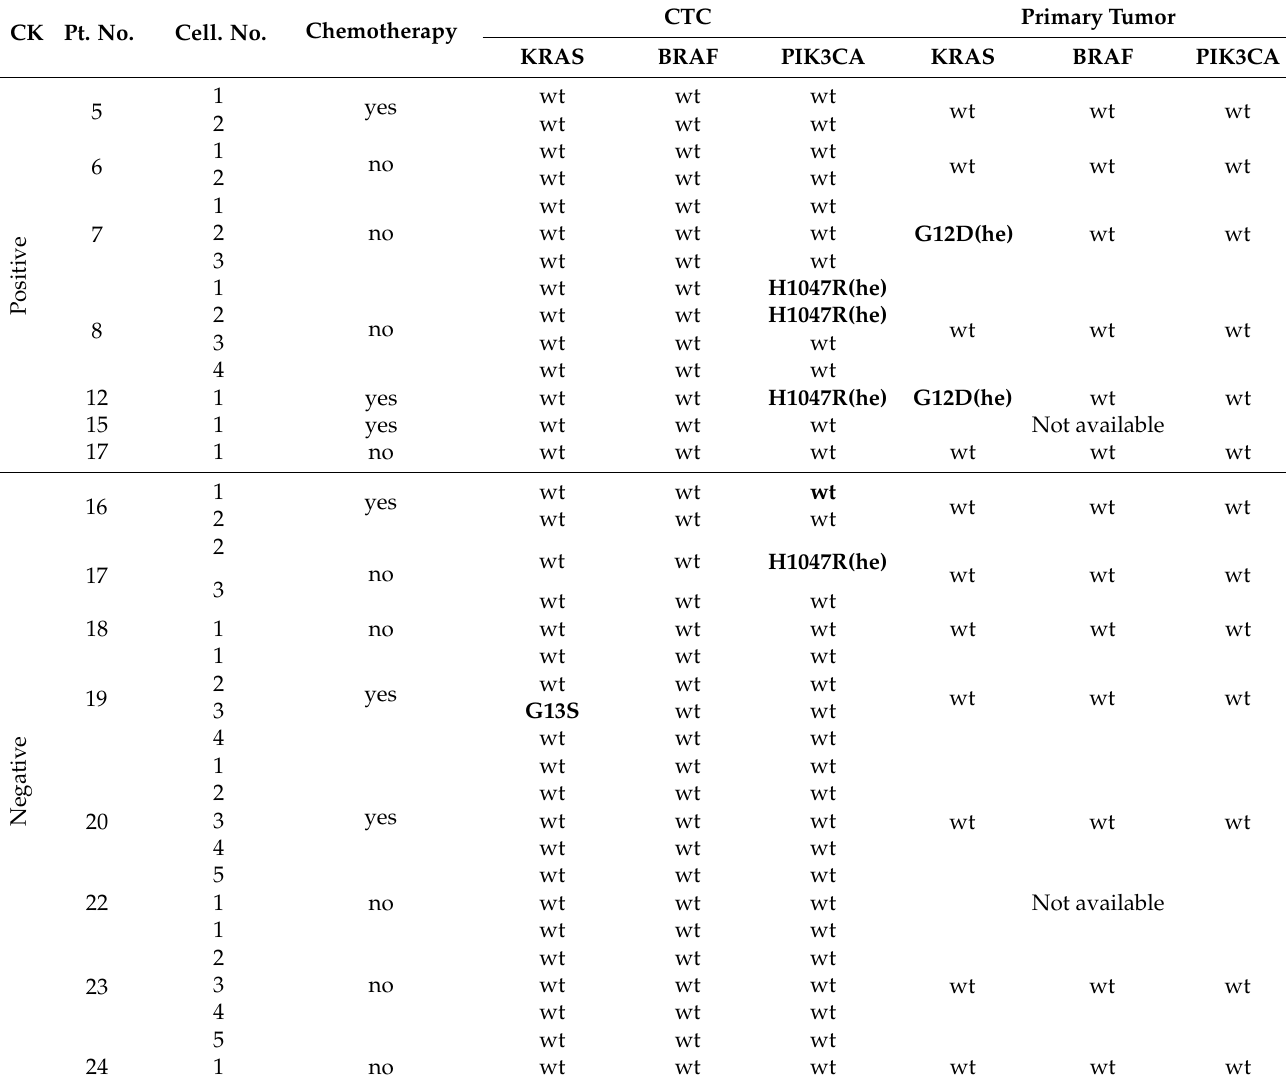
Table 3. Single cell analyses of CK-positive and CK-negative